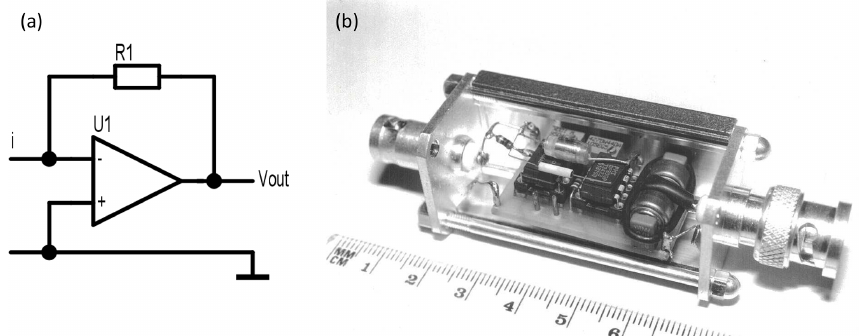
Figure 2. Current measurements. (a) Principle of a current-to-voltage converter based on an operational amplifier (U1) and a resistor (R1). (b) Implementation of a battery-powered current-to-voltage converter, built within a small in-line case, with the input current ( ∼ pA) pre- sented on the left connector and the voltage output ( ∼ mV) on the right. (The tubular air-wired component in front of the polystyrene capacitor is a high-value resistor; from Harrison, 1995a.)